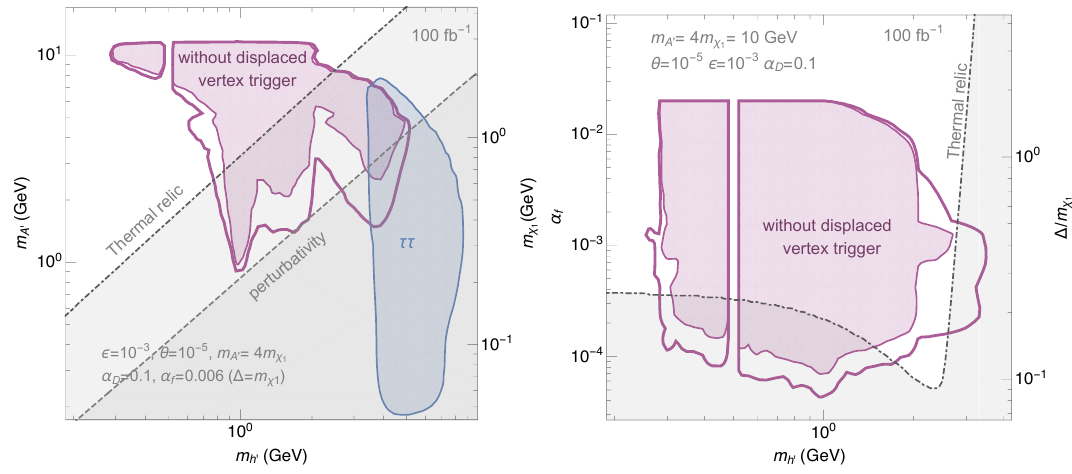
Figure 6 . Expected sensitivities of the displaced search at Belle II in the m h 0 − m A 0 plane (left) and in the m plane (right) for integrated luminosity of 100 fb − 1 . The filled regions correspond h 0 − α f to the sensitivity without invoking a displaced vertex trigger. In addition we show the region in which the ττ region contributes to the overall